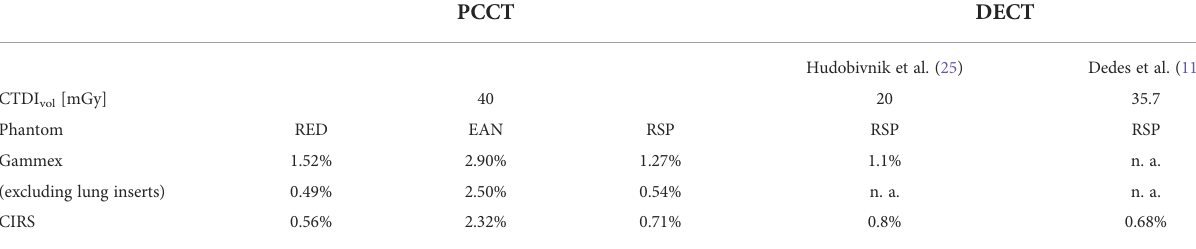
TABLE 3 RMSEs of RED, EAN, and RSP for the calibration (Gammex) and evaluation (CIRS) phantoms using VMIs at 60 and 180 keV.